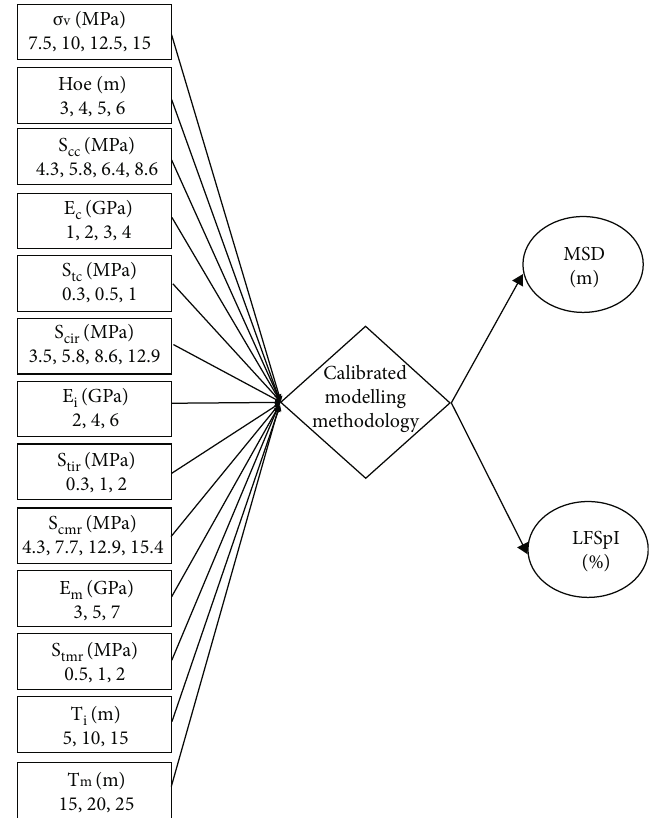
Figure 11: Experimental design of the parametric